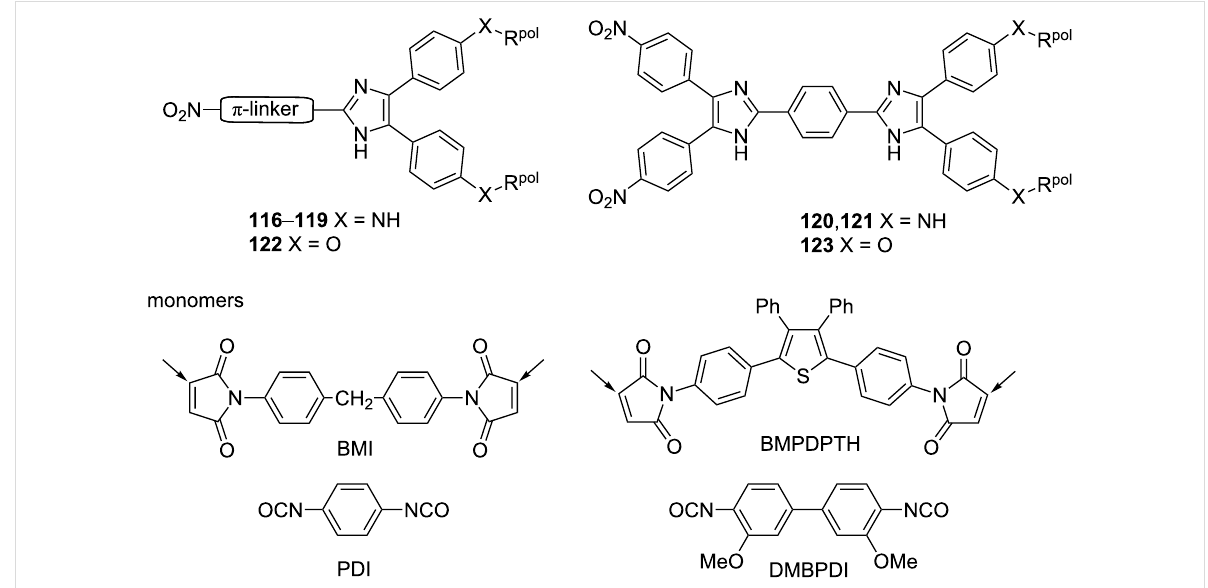
Figure 21: Amino- and hydroxy-functionalized chromophores incorporated into a polymer backbone R pol [18,50-53,122-124].